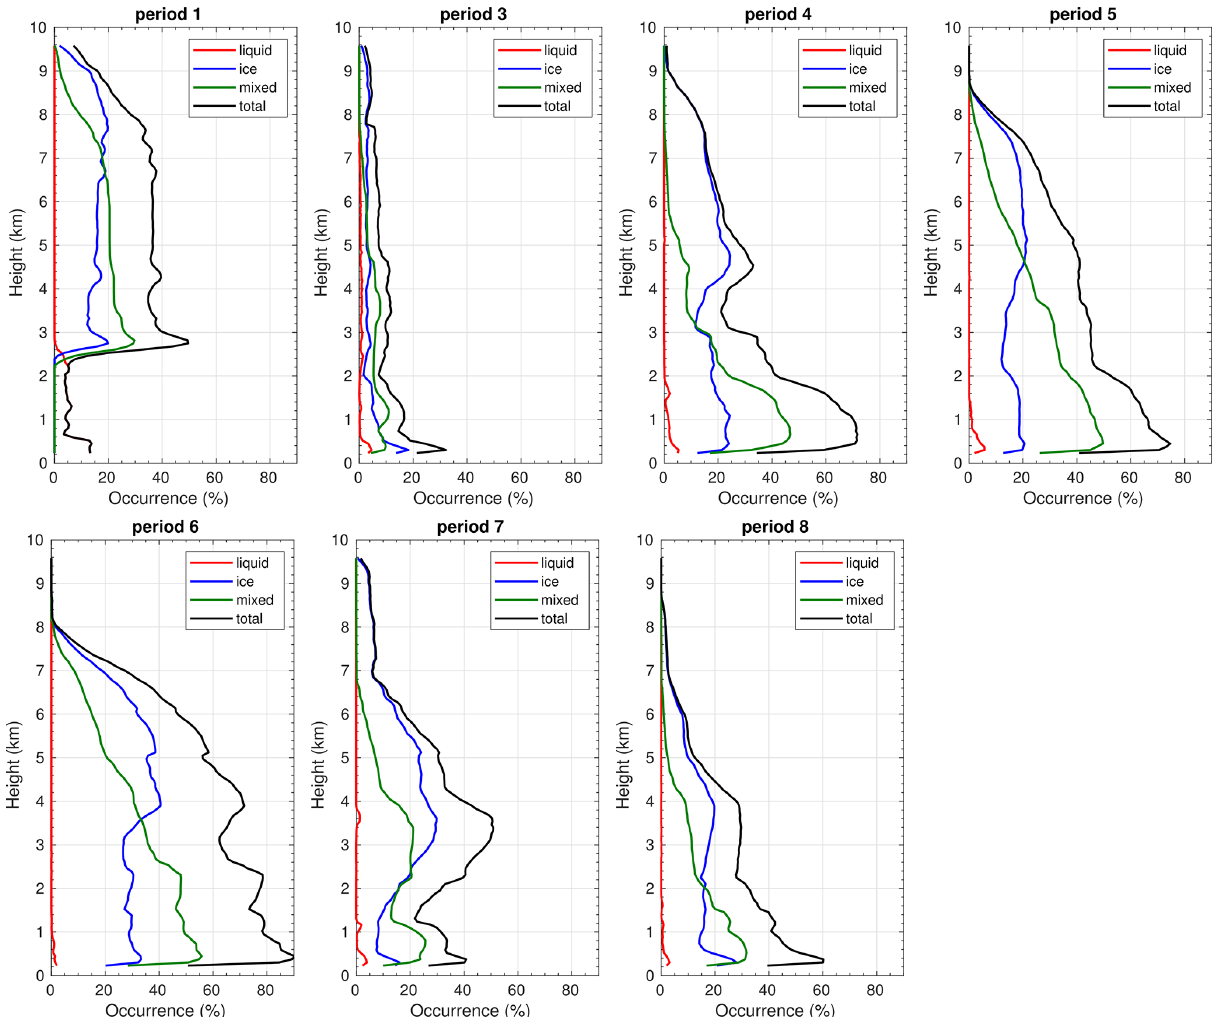
Figure 16. Mean cloud occurrence per volume for different cloud types (colour coded), obtained from the Cloudnet target classification product for the eight key